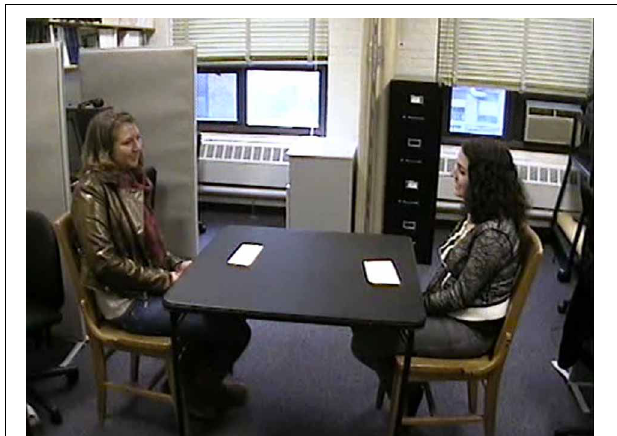
FIGURE 2 | Lab room setup for human-subjects experiment. Participants engaged in a “get-to-know-you” interaction with another random participant. Slips of paper on the table listed some conversation topic